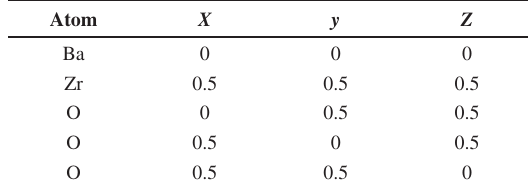
Figure 1. Characteristic XRD pattern for the BZO cubic perovskite. Symbols represent experimental diffraction data, and the base line is the difference between experimental and simulated patterns (continuous line). Table 1. Atomic positions of the BZO ions.